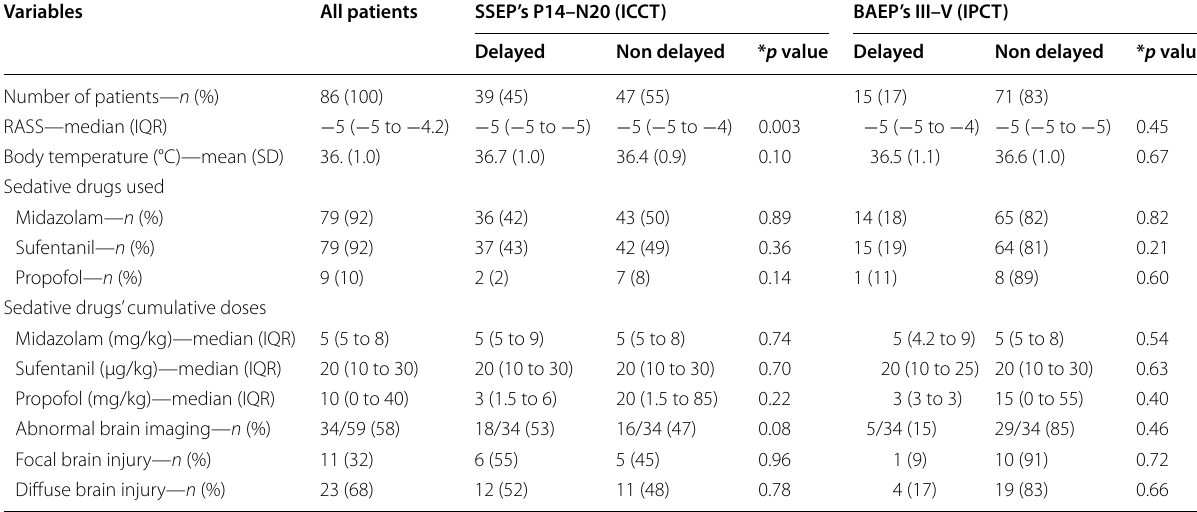
Table 5 Comparing sedative drug use and cumulative administered dose among patients with and without